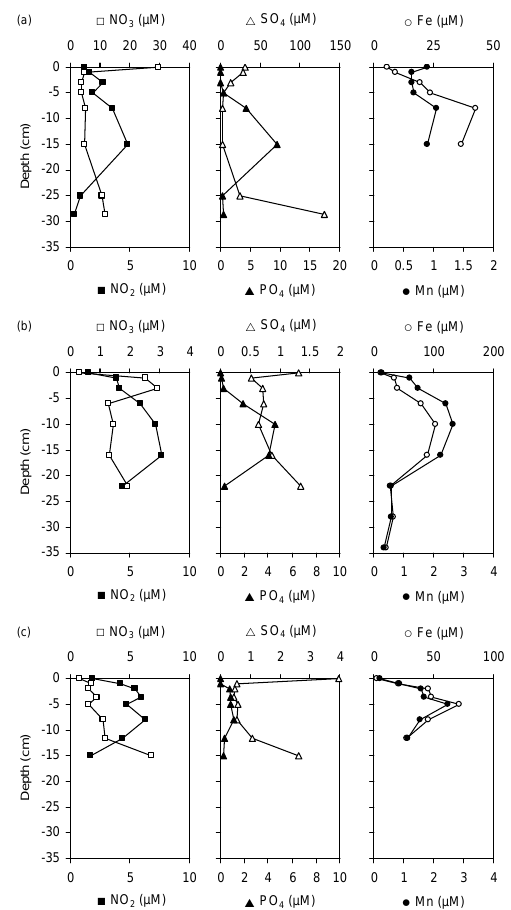
Fig. 7. Concentration–depth profiles for N-species, sulfate, phos- phate, Fe and Mn in the porewater of Lake Shirokoe (a) , Lake Yamsovey (b) and Lake Khasyrei (c) Figure 7 Audry et al.